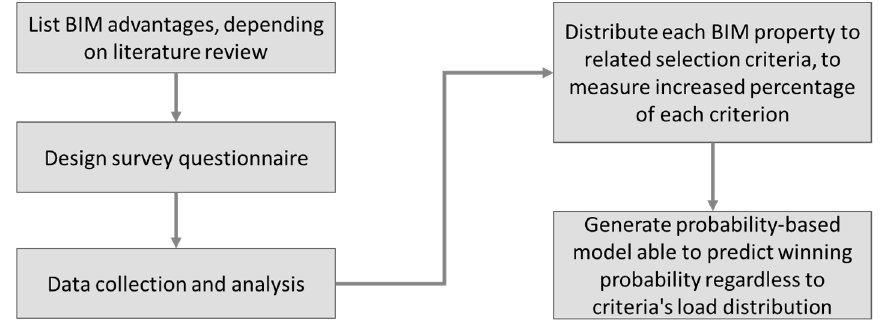
Figure 4. Methodology of questionnaire.